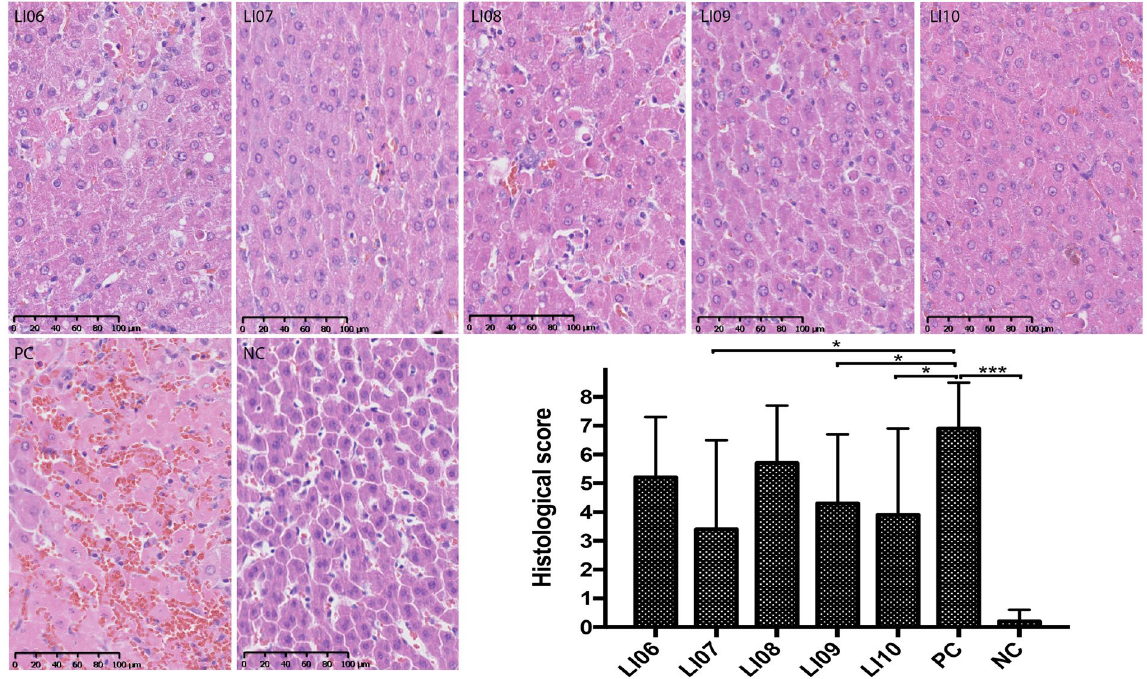
Figure 1. Effects of pretreatment with five Bifidobacterium strains on hepatic histological abnormalities during D-galactosamine (D-GalN)-induced acute liver injury. Representative images of hepatic haematoxylin and eosin (H&E) staining and histological scores of livers based on these images. Values are expressed as the mean ± SD. * p < 0.05, *** p < 0.001 compared with the positive acute liver injury control (PC)